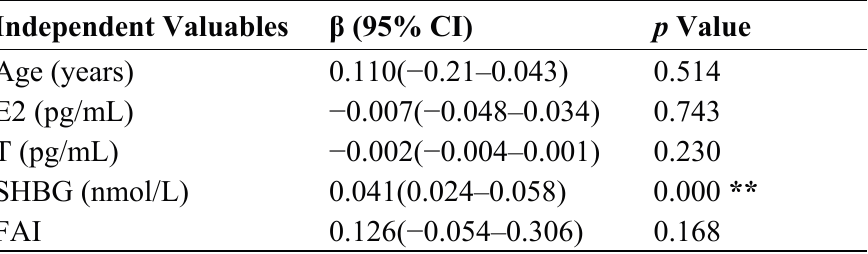
Table 3. Linear regression analysis for independent valuables and BPA